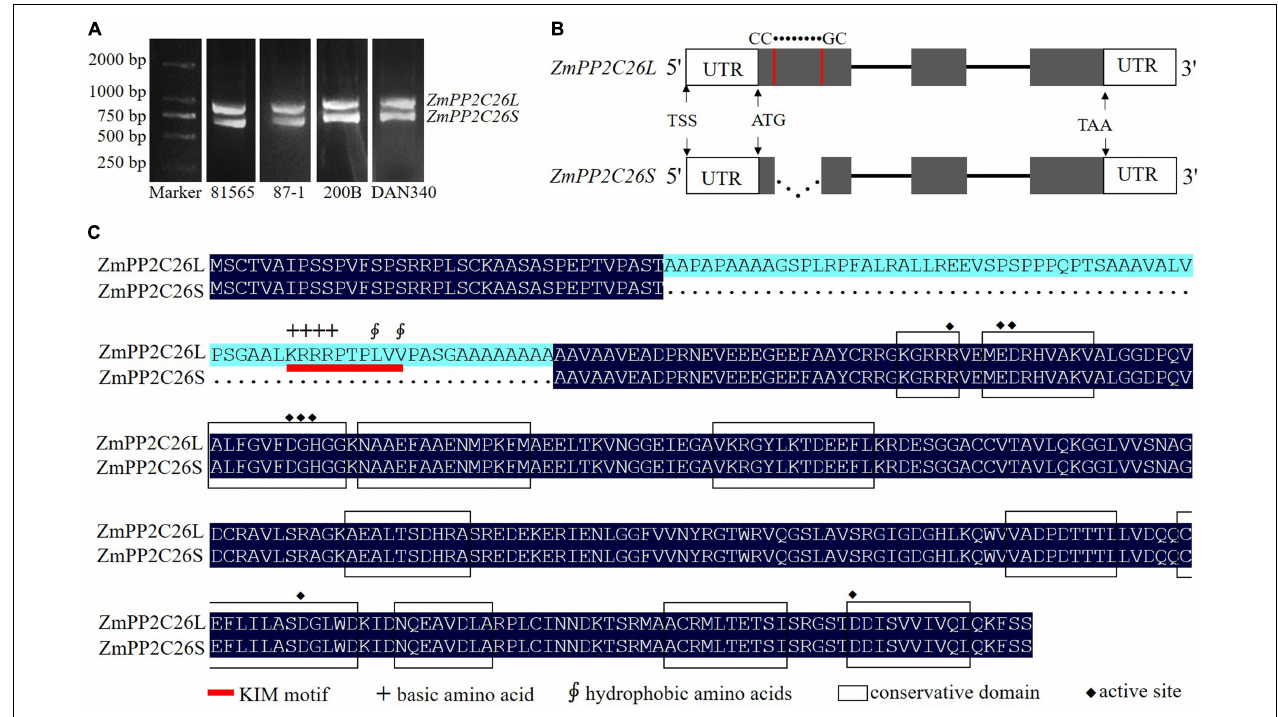
FIGURE 1 | The splicing variants of ZmPP2C26 via AFE type. (A) The ORF amplification of ZmPP2C26 gene from maize inbred lines 81565, 87-1, 200B, and DAN340. (B) The alternative splicing model of ZmPP2C26 . The gray boxes indicate exons. Lines correspond to introns; dotted line represents alternative splicing events; UTR, untranslated regions; TSS, the transcriptional start site; The splicing site is 5 (cid:48) -CC • • • • •• GC-3 (cid:48) . (C) Protein sequence alignment of ZmPP2C26L and ZmPP2C26S. Black boxes indicate conservation domain of protein phosphatase; red line indicates KIM motif; + , basic amino acid; H , hydrophobic amino acids; (cid:7) , active